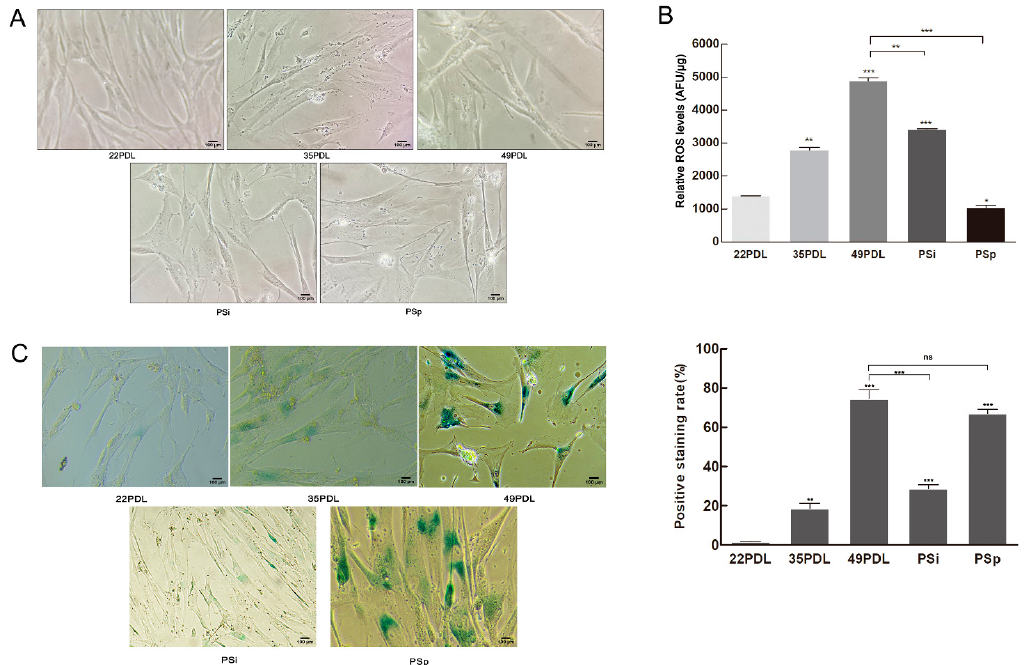
Figure 1. SA- β -gal staining and ROS level. ( A ) Cell morphology under the microscope (200×, 100 μ m). ( B ) ROS level in the cells. ( C ) The SA- β -gal staining and the blue staining rate. The β -galactosidase was dyed blue in senescent cells (200×, 100 μ m). The data are presented as the mean ± SEM ( n = 3). Compared with the 22PDL or 49PDL group, * p < 0.05, ** p < 0.01, *** p < 0.001, or ns p > 0.05.